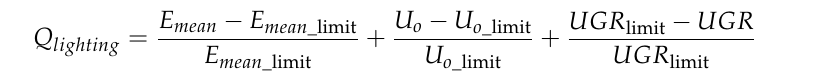
Figure 8. Average best fitness of the IPSO, PSO, and GA changed with iterations.